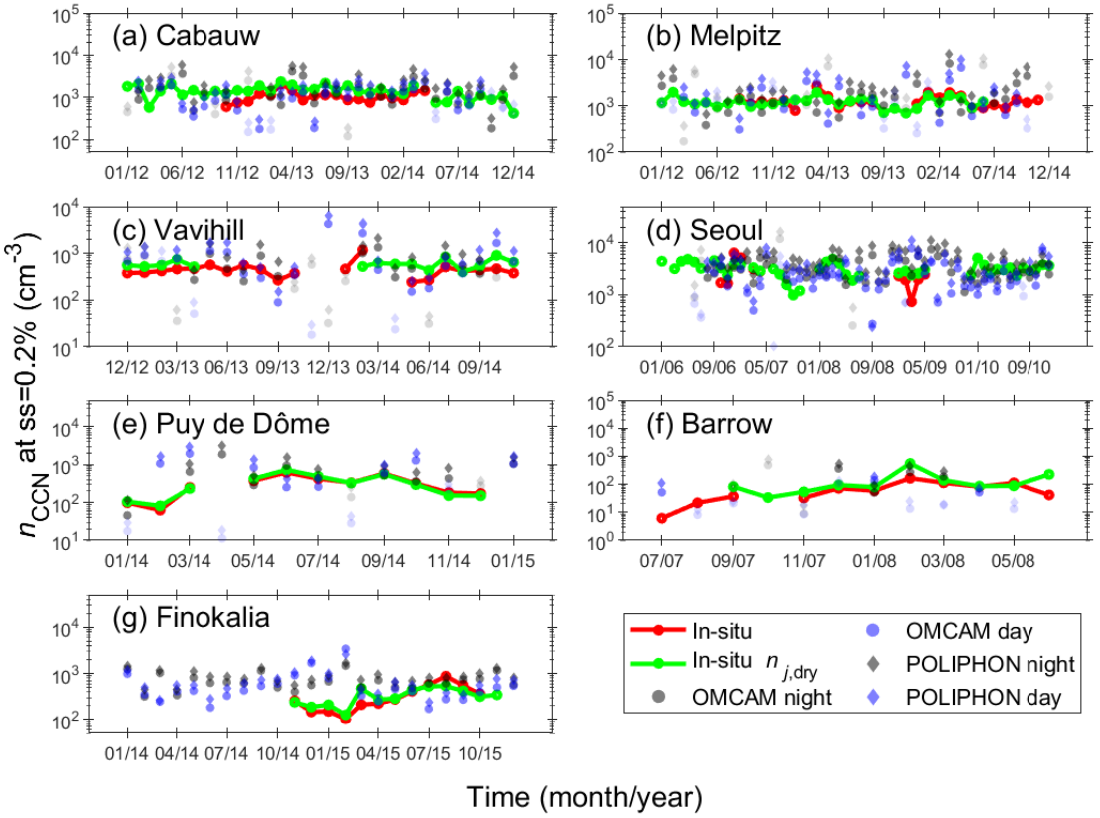
Figure 3. Monthly time series of n j ,dry (green) and n CCN (red) as derived from ground-based in situ measurements and n CCN inferred from CALIOP observations using the OMCAM (gray dots for nighttime data and blue for daytime data) and POLIPHON (gray diamonds for nighttime and blue for daytime data) algorithms at Cawbauw ( a ), Melpitz ( b ), Vavihill ( c ), Seoul ( d ), Puy de Dôme ( e ), Barrow ( f ), and Finokalia ( g ) stations. The semi-transparent data points are for the cases where the number of CALIOP data bins with finite aerosol retrievals used to produce the monthly average are less than 100.